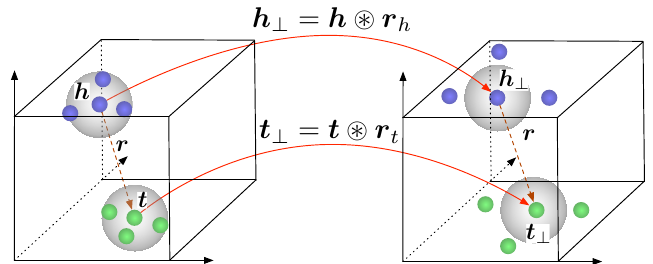
Figure 2. The principle of the TransET model.